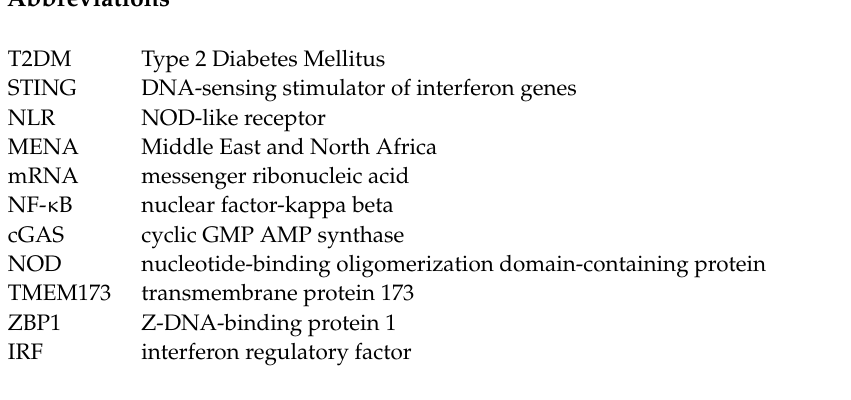
Figure S7. showing the STRING interaction between the 6 chosen mRNAs (TMEM173, DDX58, ZBP1, CHUK, NFKB1 and HSPA1B) obtained from Gene Cards data base, Table S1. The research group’s medical and physical